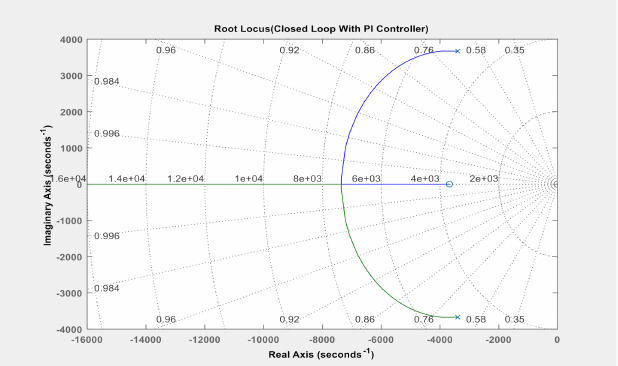
Figure 14. Root locus of the closed loop T.F of the inner current control loop.